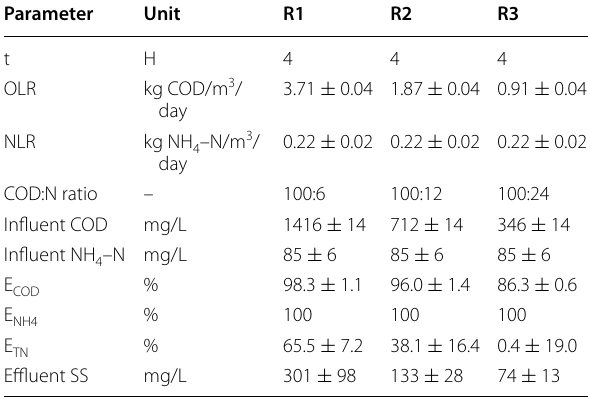
Cycle length (t); organic and nitrogen loading rate (OLR, NLR); COD:N ratio; influent COD and NH 4 –N concentration; removal efficiency (E) of COD, NH 4